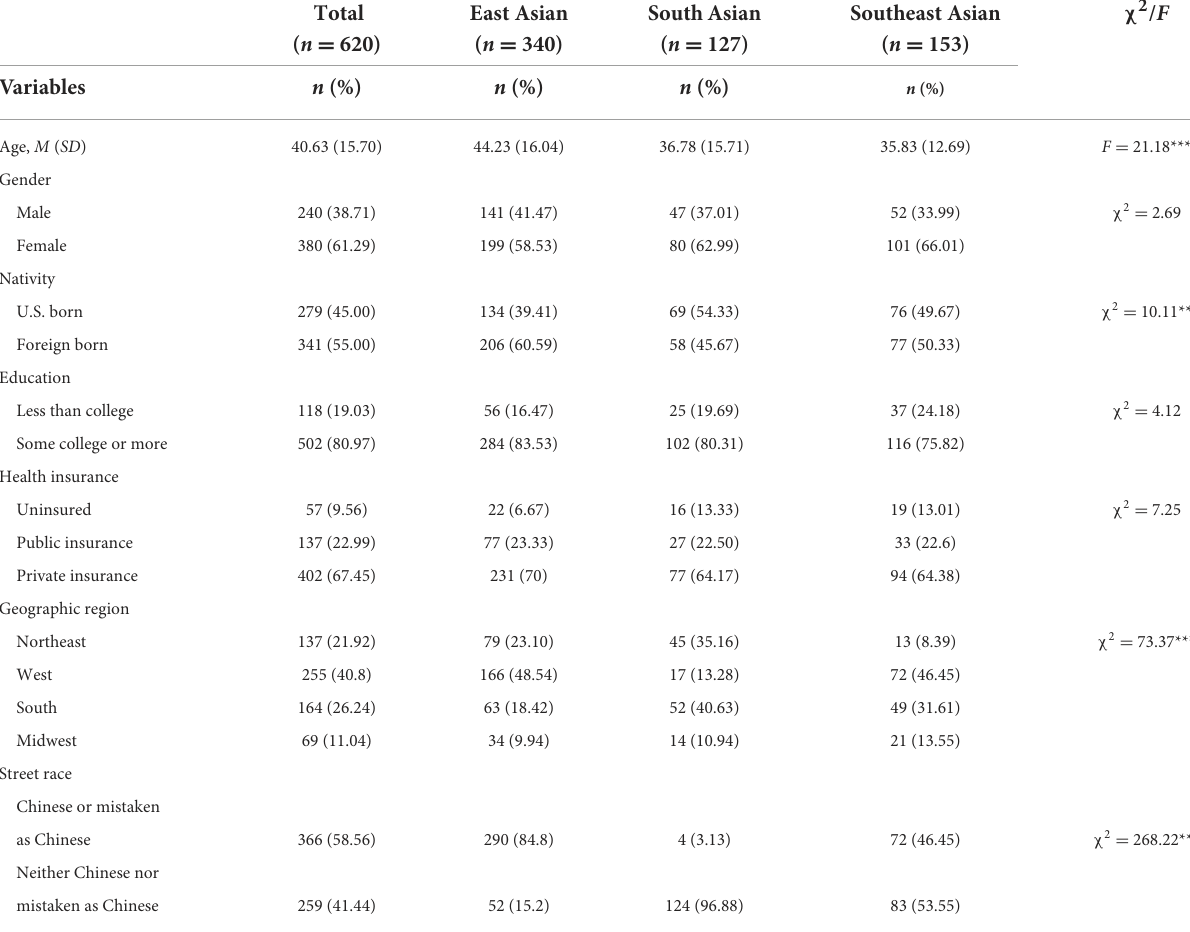
TABLE 1 Sample characteristics by ethnic